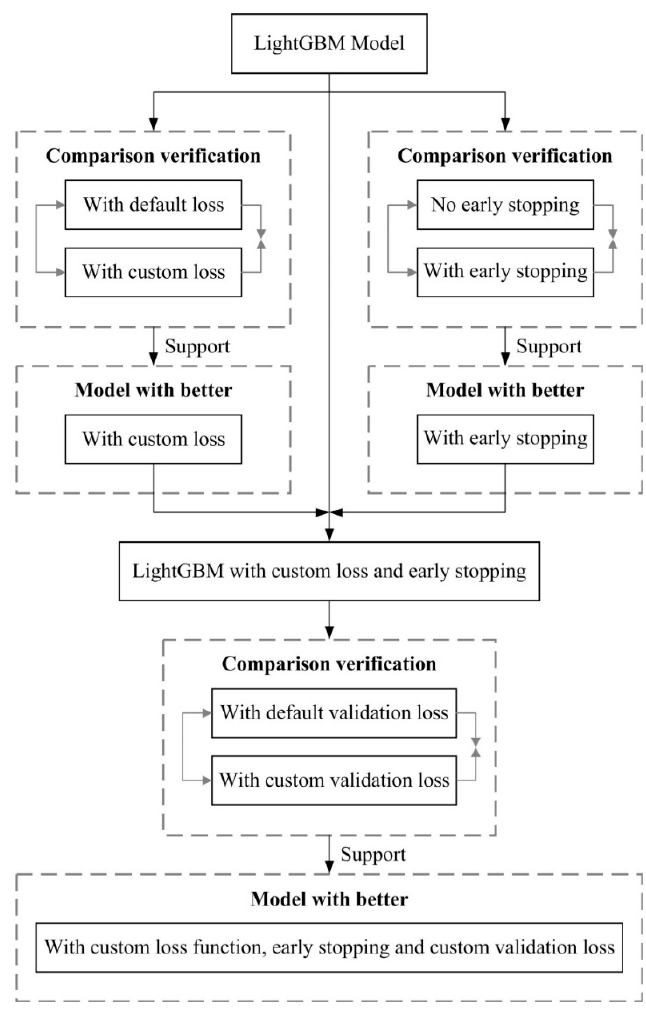
Figure 4. The flowchart of verification comparison. Table 1. Model fitting condition under different comparisons.